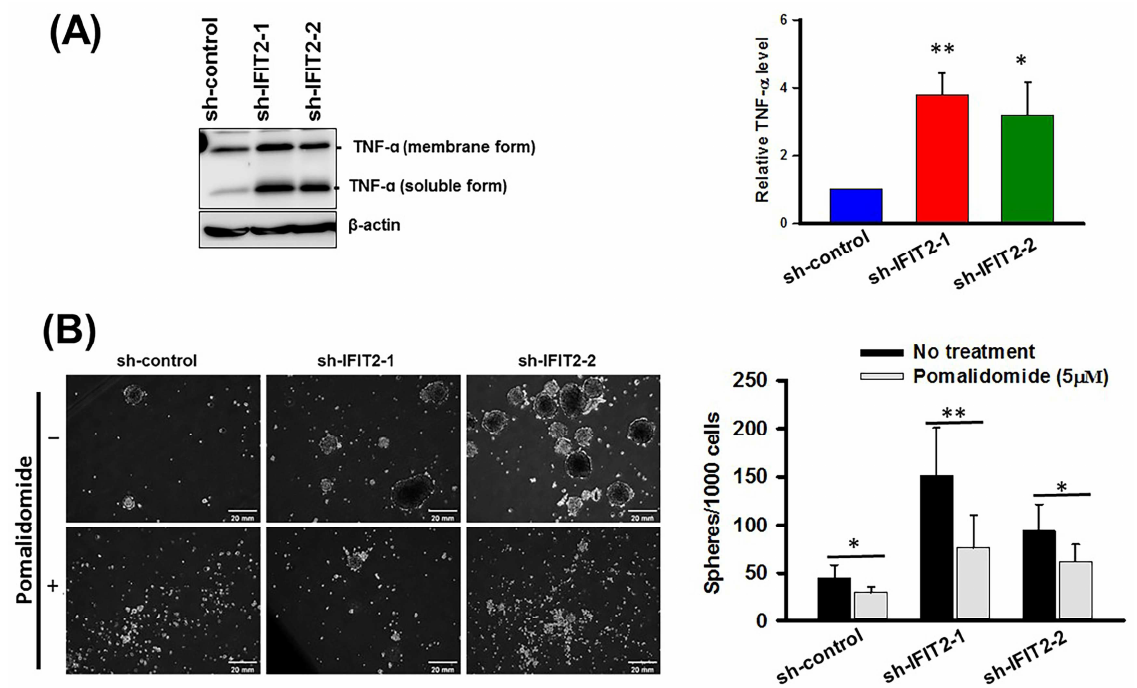
Figure 5. Effect of pomalidomide on spheroid formation in stable IFIT2 knockdown cells. ( A ) The TNF- α protein levels in sh-control and stable IFIT2 knockdown cells were determined by Western blotting (left panel) and ELISA (right panel). β -actin expression was used as an internal control in Western blotting; ( B ) Representative image of spheres with or without pomalidomide (5 µM). The quantitative data were average of seven independent experiments. The symbols * and ** indicate statistically significant differences at p < 0.05 and p < 0.01, respectively.